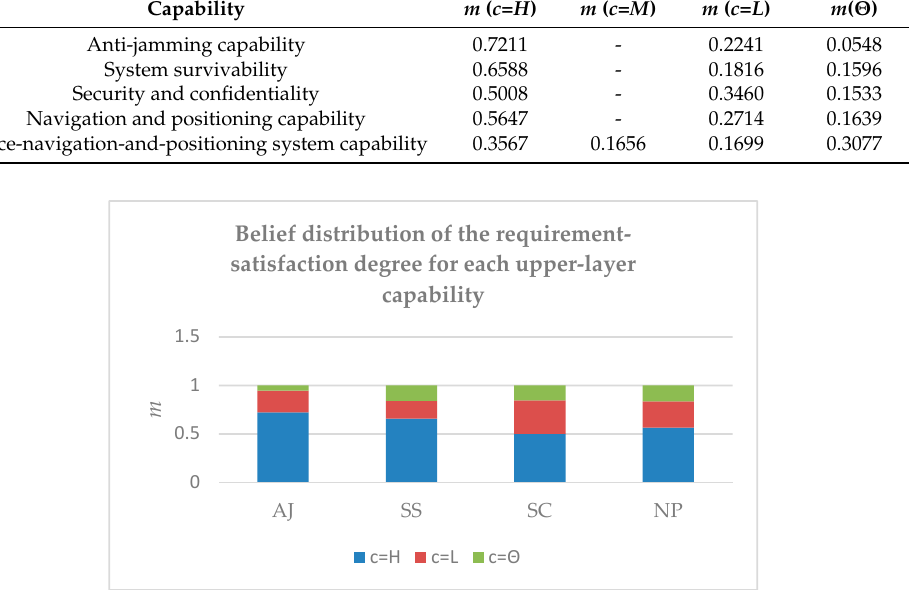
Figure 3. The belief distribution of the requirement-satisfaction degree of each upper-layer capability.